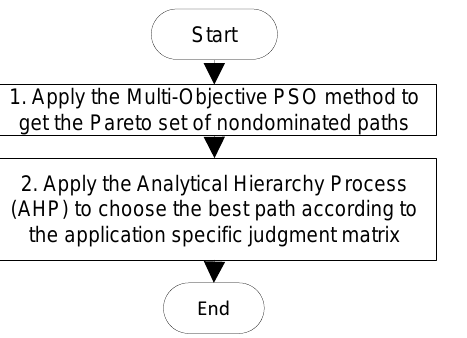
Figure 4. A flowchart of the proposed method for finding the best data path.